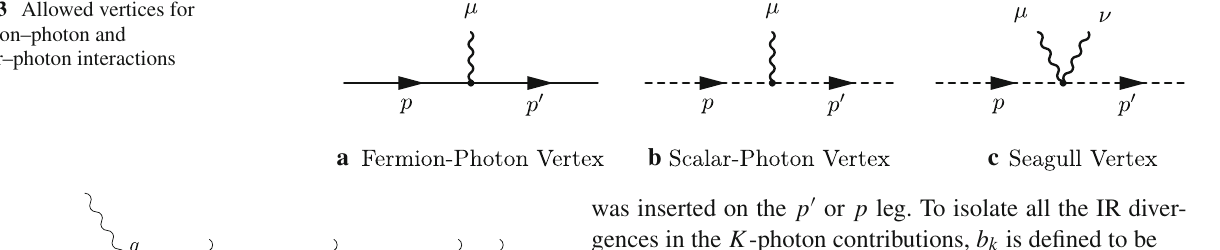
Fig. 3 Allowed vertices for fermion–photon and scalar–photon interactions